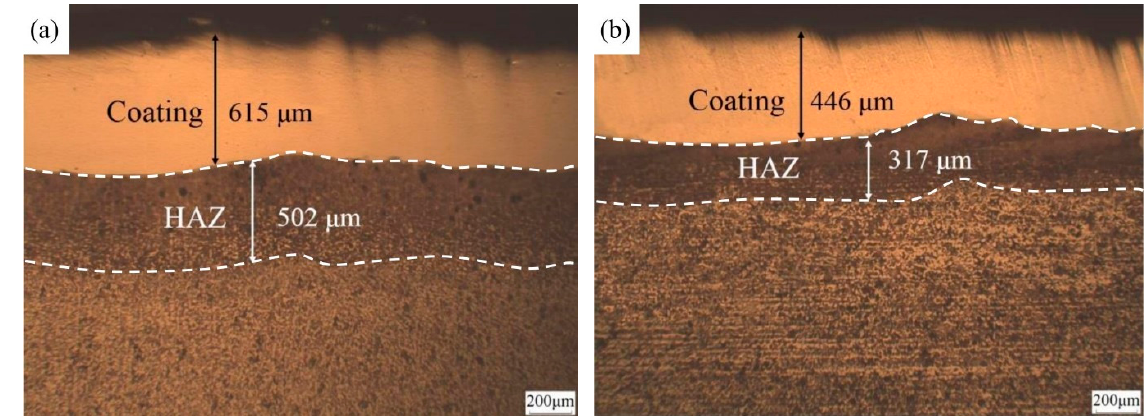
Figure 4. The cross − sectional microstructure of coating: ( a ) GF; ( b ) HF.